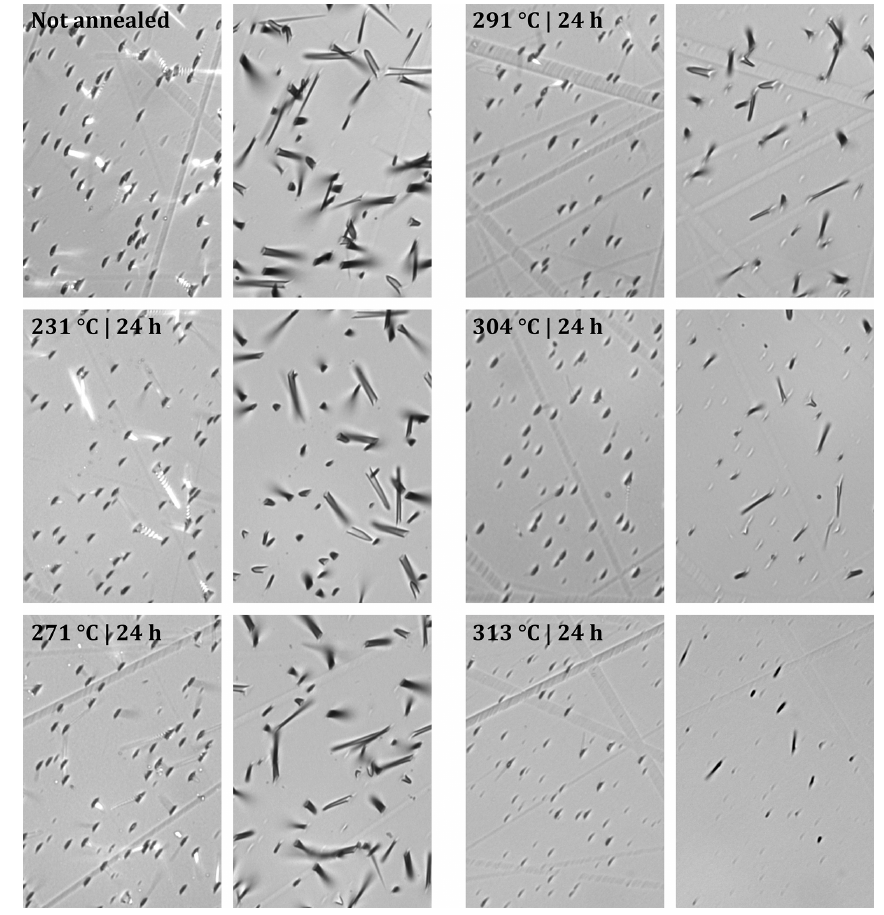
Figure 6. Pairs of reflected-light (RL) and transmitted-light (TL) images of the same areas in prism faces of an unannealed Durango apatite and five annealed under different temperature–time conditions. All samples contain induced fission tracks and were etched for 20s in 5.5M HNO 3 at 21 ◦